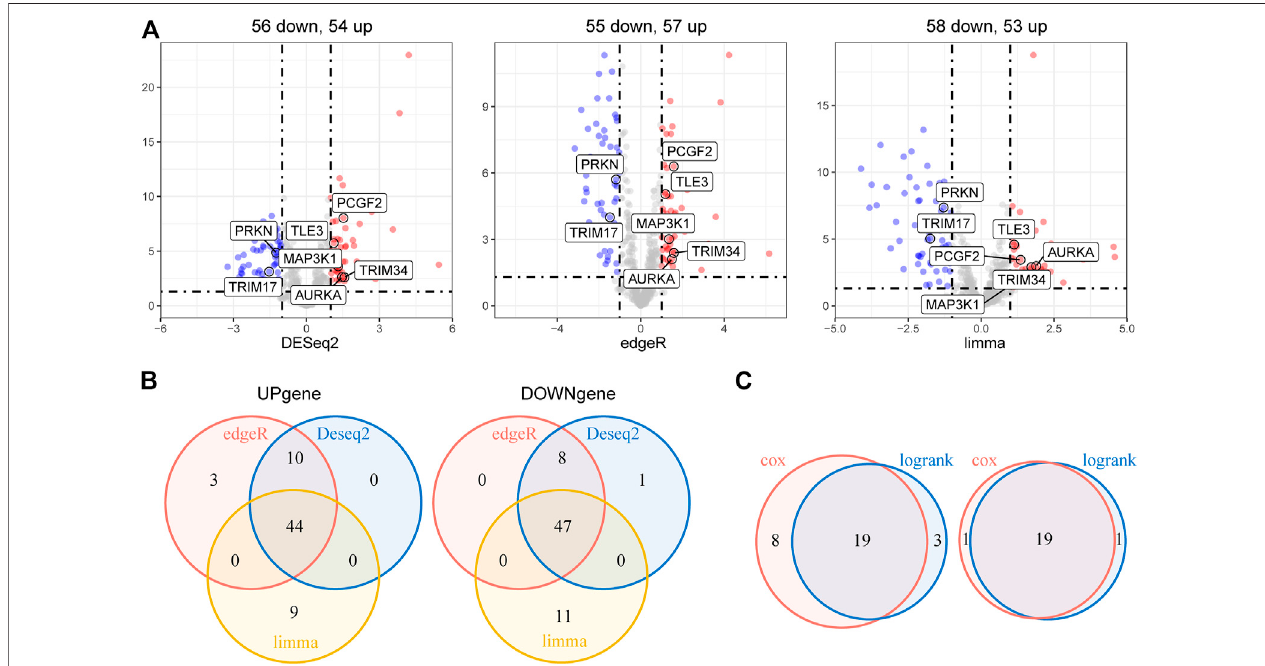
FIGURE 2 | Identi fi cation of E3-related DEGs with prognostic value in LGG. (A) Volcano plot of E3-related DEGs between 451 LGG samples and fi ve normal brain samples identi fi ed using edgeR, limma, and DESeq2 algorithms, with the cut-off criterion p < 0.05 and |log 2 FC| ≥ 1. Blue dots: signi fi cantly downregulated genes; red dots: signi fi cantly upregulated genes. (B) Venn diagram of the overlapping E3-related DEGs screened by the three differential expression analyses. (C) Venn diagram of theintersectionforoverallsurvival – correlatedE3-relatedDEGsidenti fi edusingunivariateCoxregressionanalysisandlog-rankstatisticaltestwiththecut-offcriteria of p < 0.05. Left, predicted favorable prognosis; right, predicted poor prognosis.